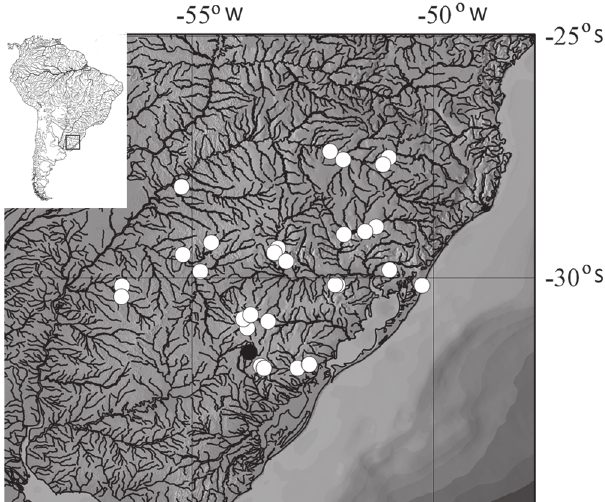
Fig. 3. Map of southern Brazil and Uruguay, showing the distribution of the material examined of Astyanax dissensus . Some symbols represent more than on lot or locality. Black circle = type